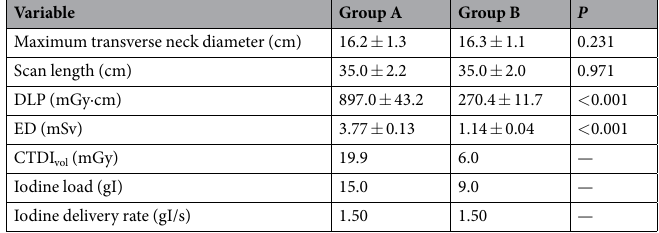
Table 2. Radiation dose, iodine load and iodine delivery rate obtained between group A and group B. Abbreviations: CTDIvol, volume computed tomography dose index; DLP, dose length product; ED, effective